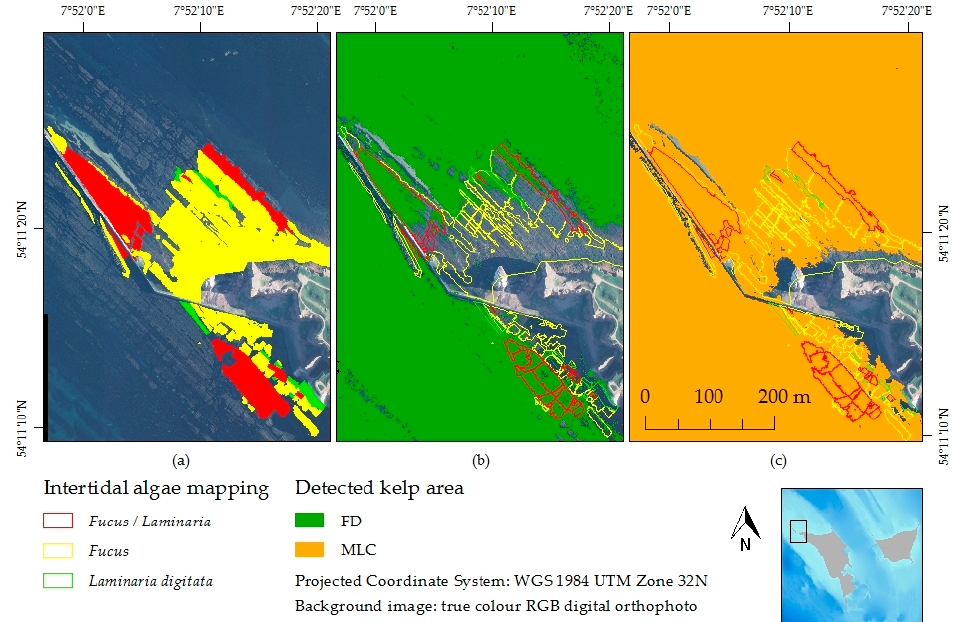
Figure 9. Intertidal field mappings compared to MLC and FD kelp detection results. Intertidal field mapping results ( a ); field mapping compared to FD results ( b ); field mapping compared to MLC results ( c ).